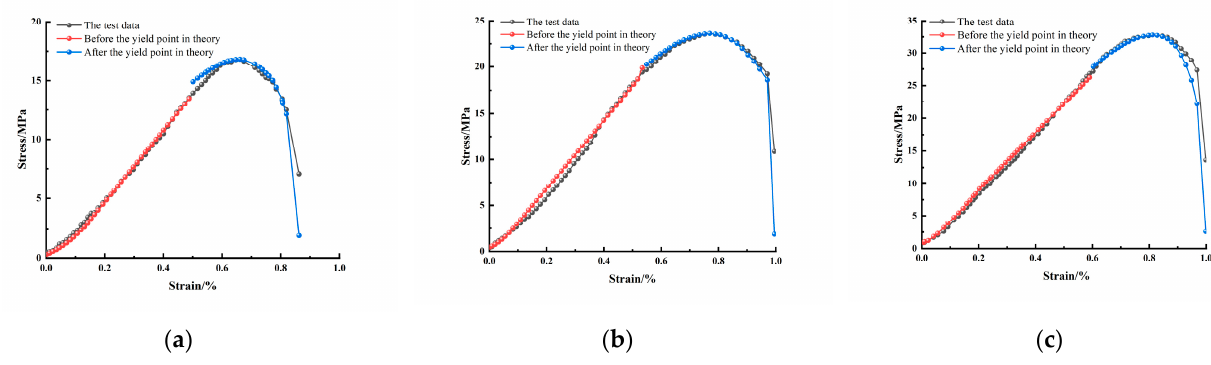
16 of 20 Figure 13. Comparison between experimental data and model data. ( a ) T = 25 °C; ( b ) T = − 5 °C; ( c ) T = − 10 °C; ( d ) T = − 15 °C. The following inferences can be drawn by comparing the test results with the mod- eling results. 1.